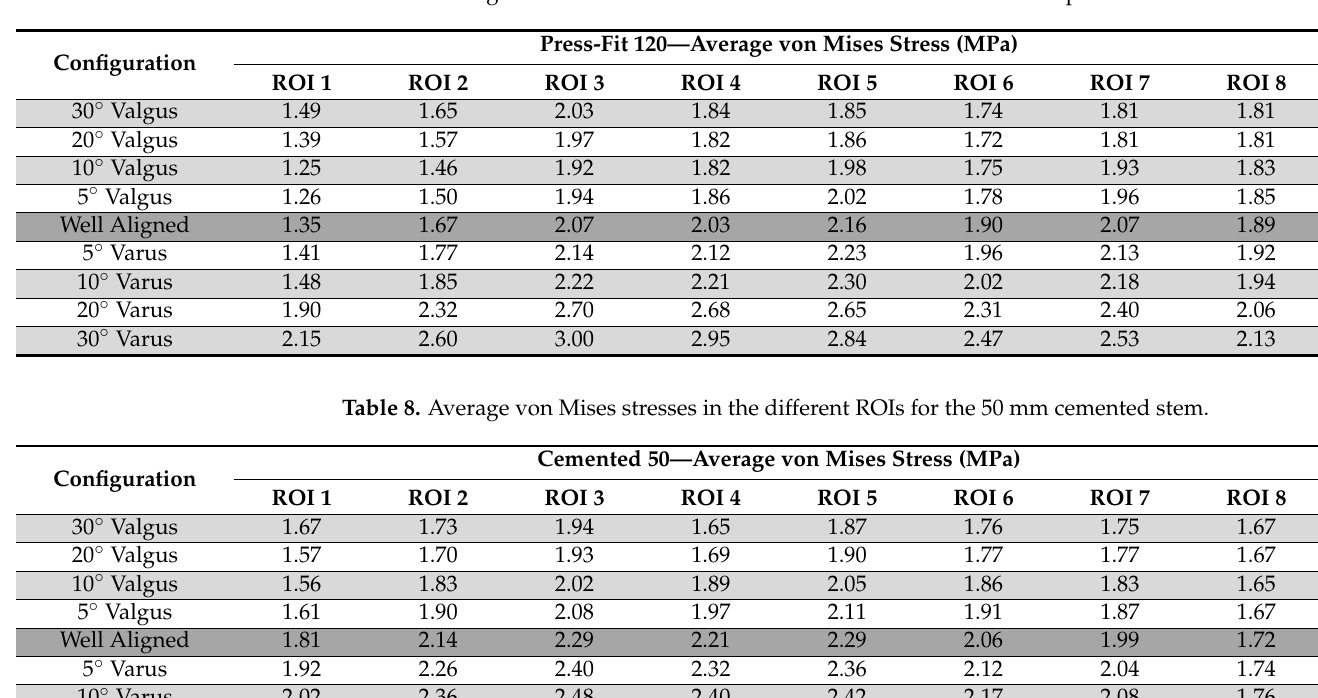
Table 7. Average von Mises stresses in the different ROIs for the 120 mm press-fit stem.